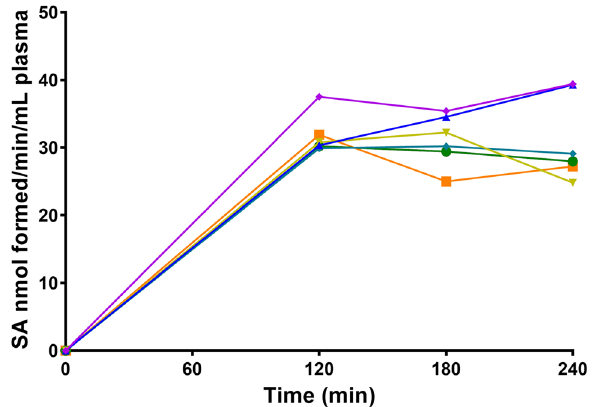
Figure 2. Esterase activity (SA formed) as a function of time in HS (n = 6) incubating ASA 40 mM as a substrate.